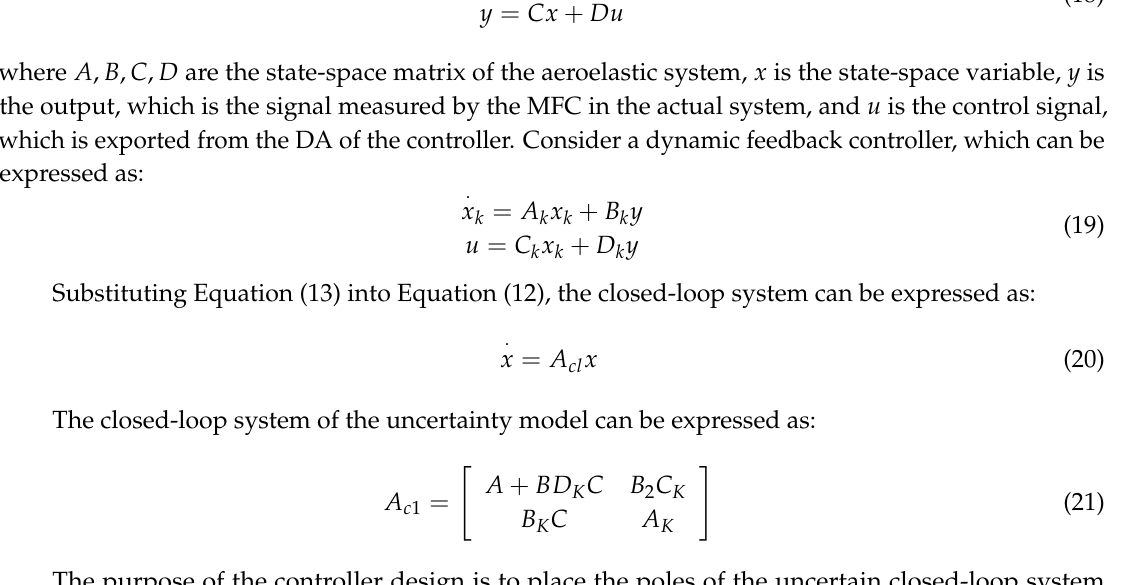
Figure 12. Block diagram of flutter control system of wing model for wind tunnel tests.